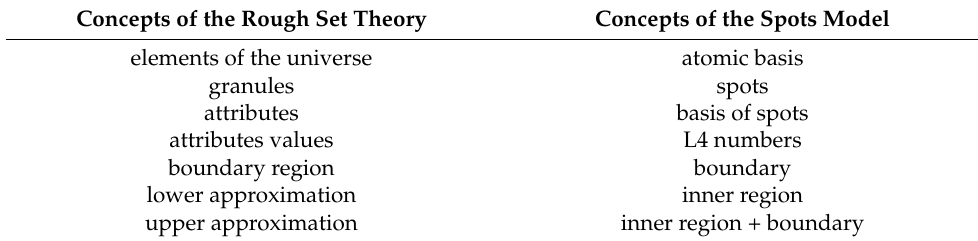
Table 2. Analogies between the concepts of rough sets and spots. Concepts of the Rough Set Theory Concepts of the Spots Model elements of the universe atomic basis granules spots attributes basis of spots attributes values L4 numbers boundary region boundary lower approximation inner region upper approximation inner region +